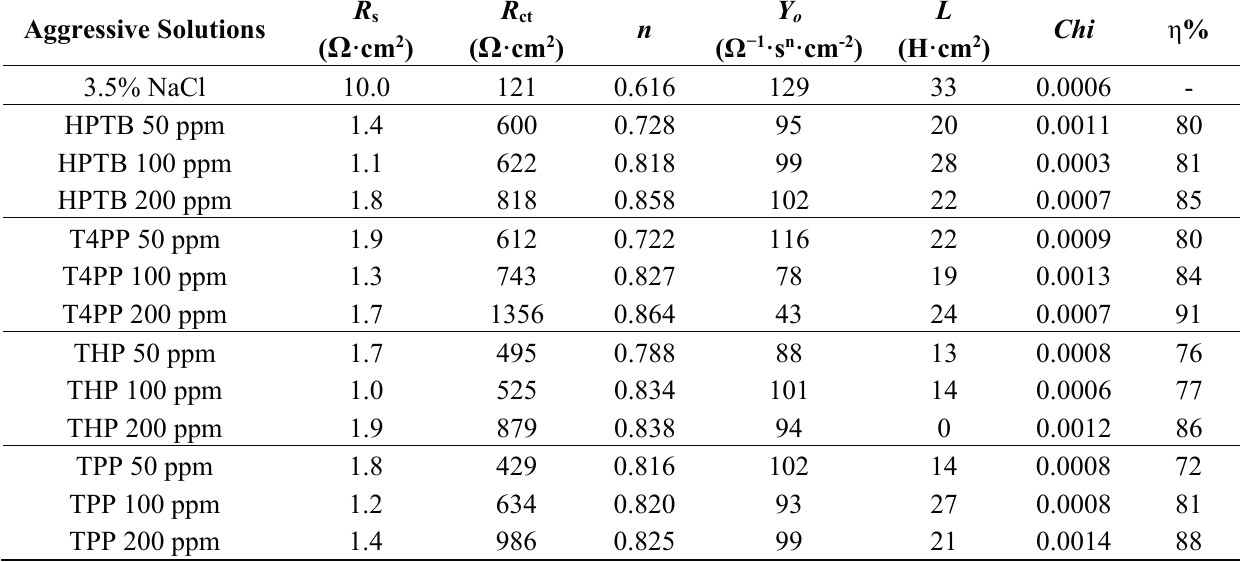
Table 1. Electrochemical impedance parameters for N80 steel in 3.5% NaCl solution saturated with CO 2 in without and with various concentrations of the studied porphyrins.